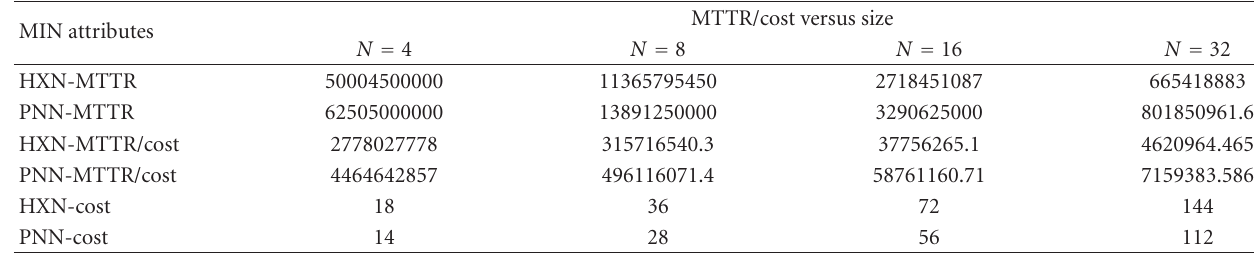
Table 27: Values of MTTR of comparative